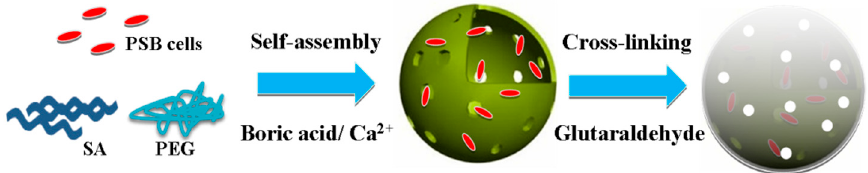
Figure 3 . Schematic diagram of preparation of the photosynthetic bacteria (PSB)-encapsulated hydrogel macrosphere.